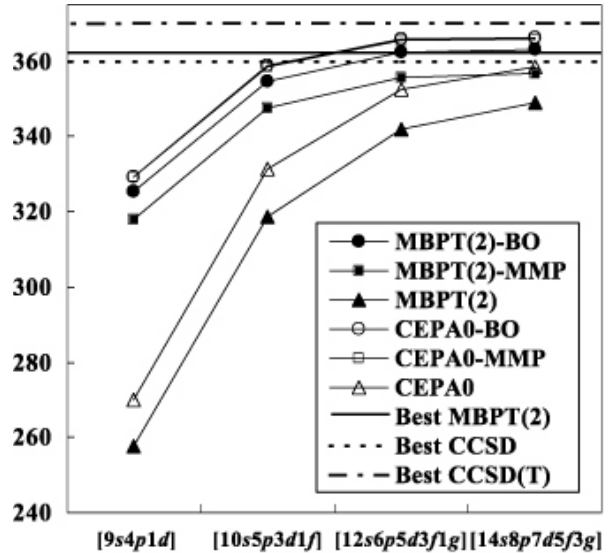
Figure 2. Convergence of the correlation energy of H denote the biorthogonal and modified MP methods,